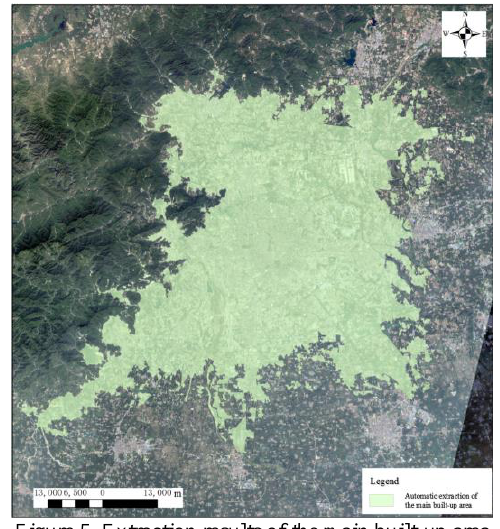
Figure 5. Extraction results of the main built-up area